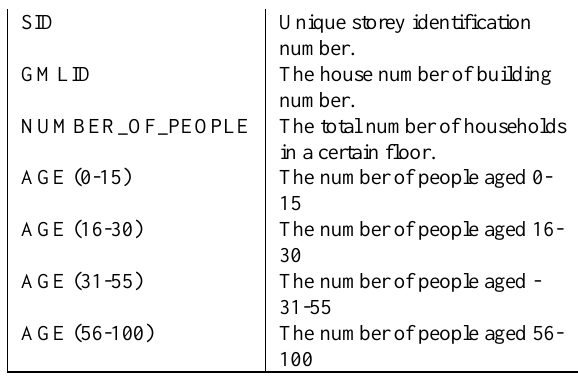
Table 3. Household data description